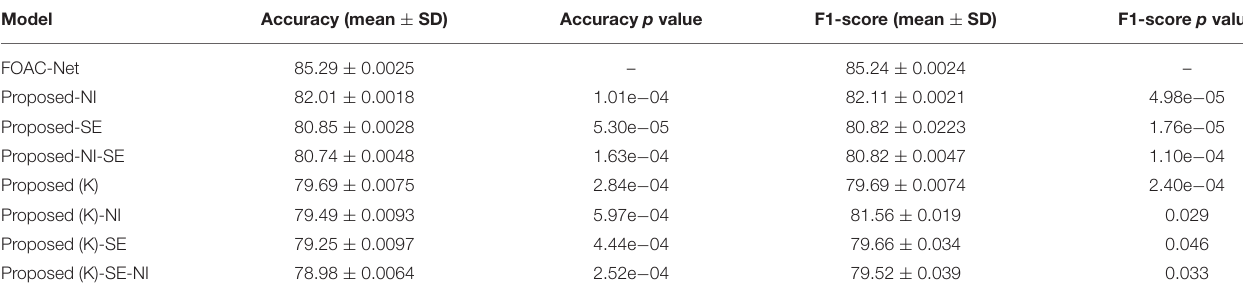
TABLE 3 | Ablation study with mean standard